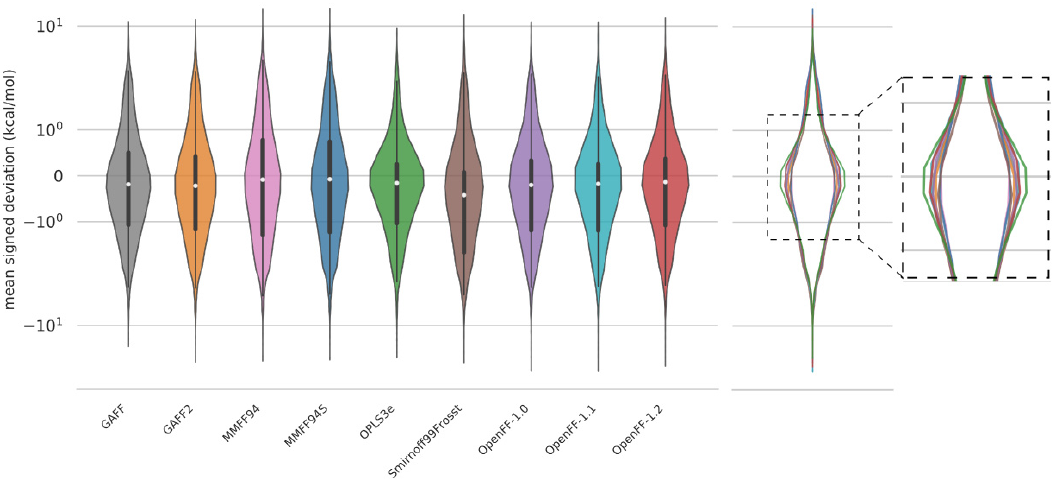
Figure 4. Violin plots of the mean signed deviations of MM conformer energies relative to QM conformer energies as computed in Equation 3. The energy MSDs only take into account structures matched within 1 Å of the QM reference structure, so there are minor differences in the amount of data used to plot each violin (see text). To correct for this, each plot was scaled to the same area. The vertical axis is shown on a logarithmic scale. An overlay of the violin plots on the right panel better shows the subtle distinctions between the force fields in the most populated region, near zero error. An equivalent graph with an RMSD threshold of 0.3 Å is shown in the Extended data , Figure S.2 93